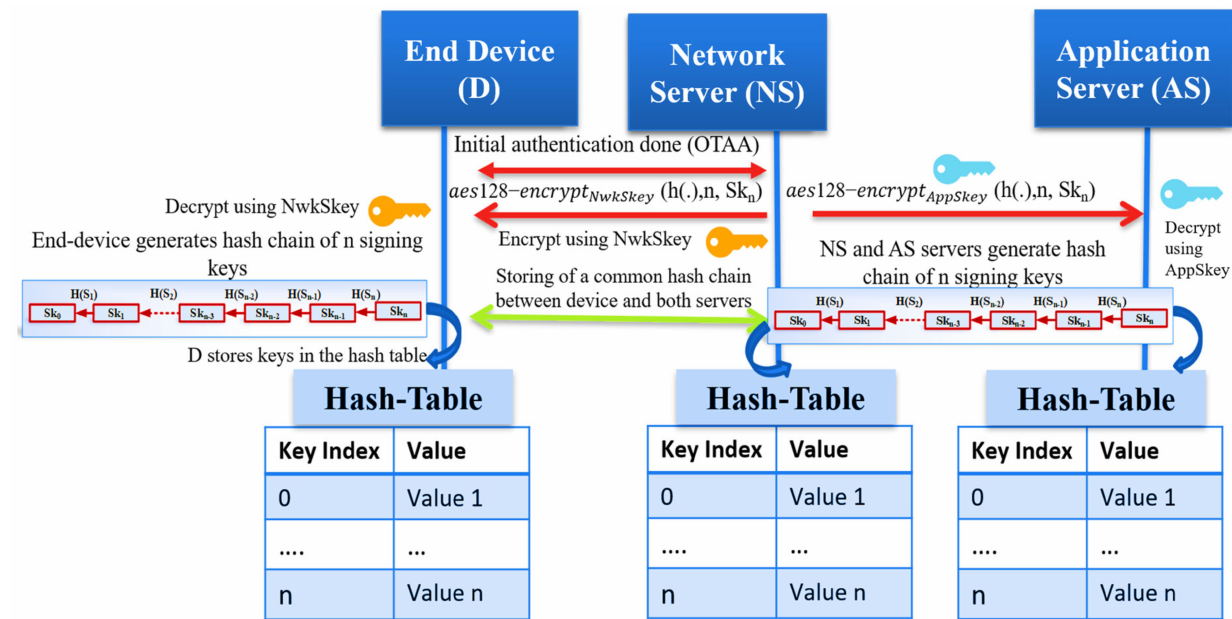
Figure 6. The proposed hash chain generation in LoRaWAN